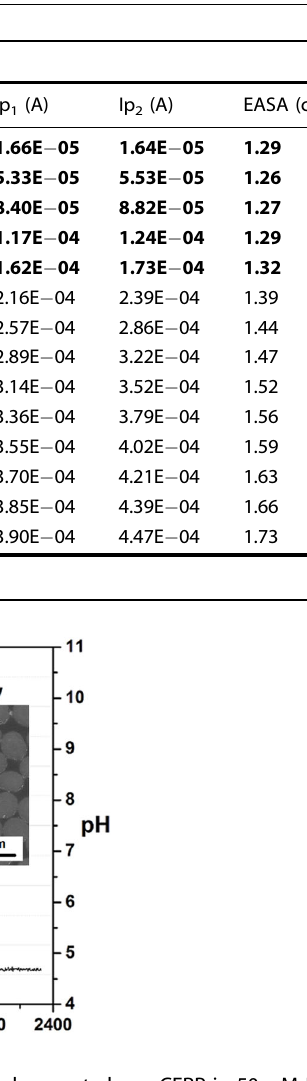
Fig. 5 pH and current density pro fi les on CFRP subjected to stepped polarization. Measured pH and current above CFRP in 50 mM NaCl with step-wise change in applied polarization (all potentials are measured versus saturated calomel